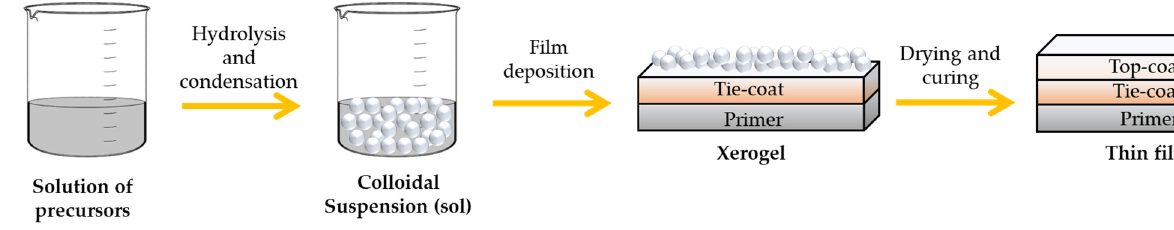
Figure 2. Subsequent stepwise sol-gel process for functional coating fabrication.